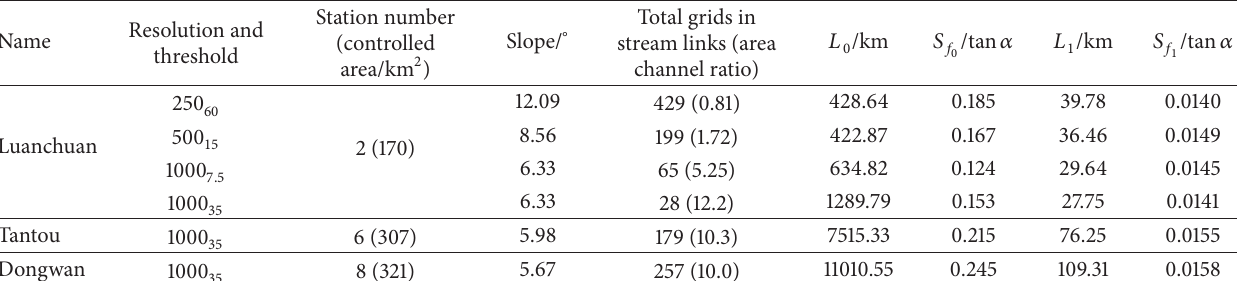
Table 2: Statistics information of influence